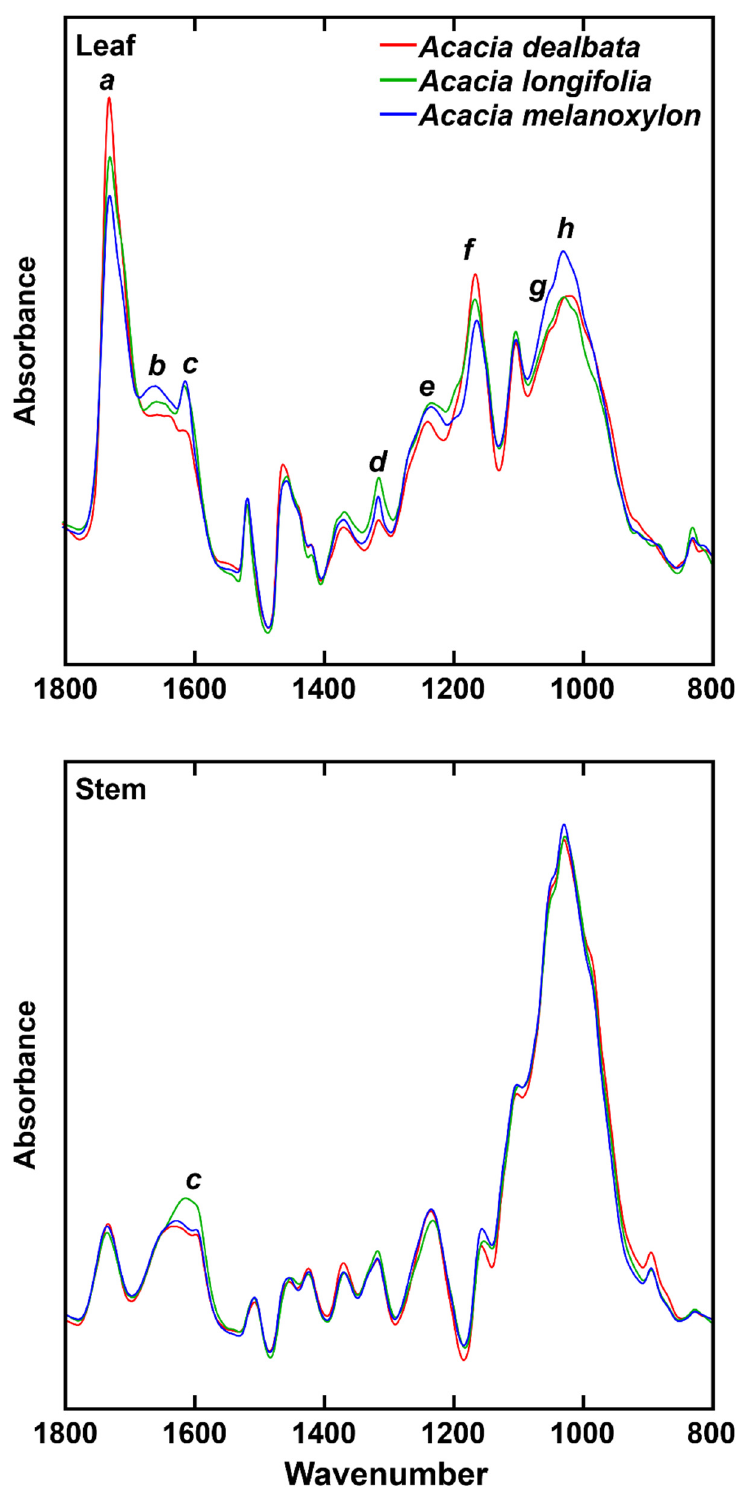
Figure 1. Mean FTIR-ATR spectra of leaf and stem samples of three Acacia spp. in the range 1800–800 cm − 1 . Spectral bands: a , 1728 cm − 1 ; b , 1640 cm − 1 ; c , 1612 cm − 1 ; d , 1314 cm − 1 ; e , 1238 cm − 1 ; f , 1166 cm − 1 ; g , 1055 cm − 1 ; h , 1030 cm − 1 .